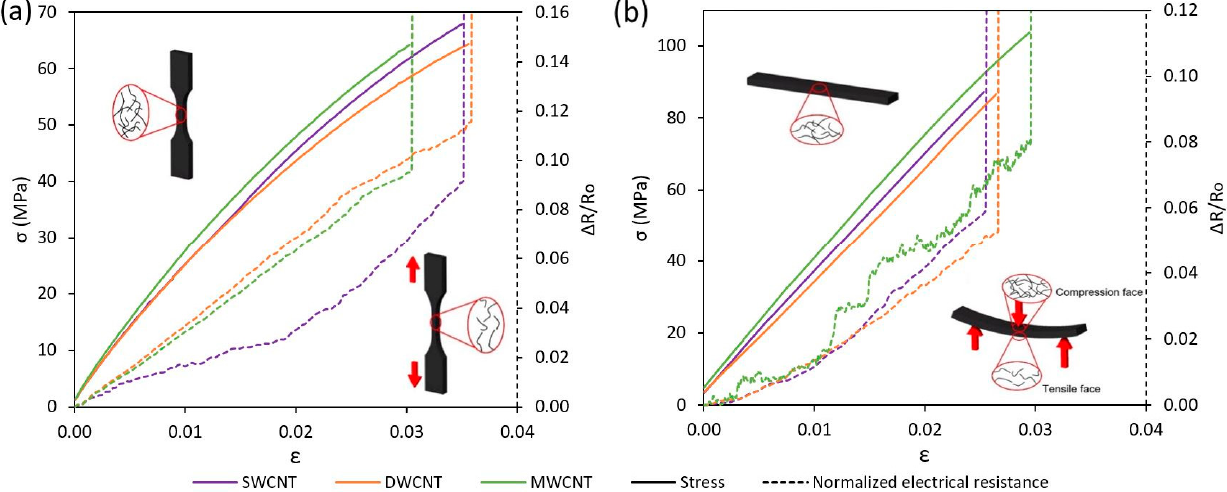
Figure 3. Examples of electromechanical tests for specimens doped with 0.1 wt.% CNTs in tensile ( a ) and three-point bending ( b ) load conditions.